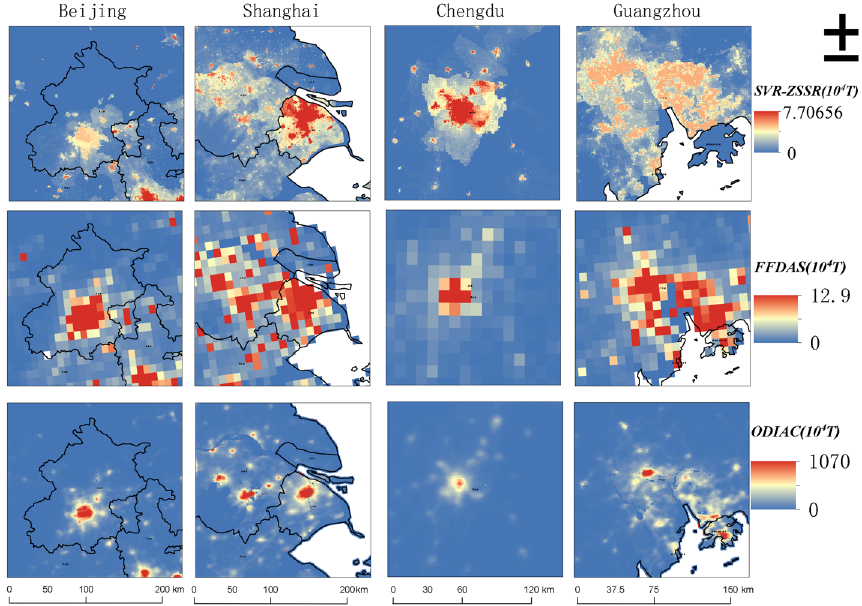
Figure 6. Comparison of SVR-ZSSR model results, FFDAS database, and ODIAC database. The figs were generated using the ArcGIS Desktop (ESRI, Inc, Version 10.7, https:// deskt op. arcgis. com/ zh-